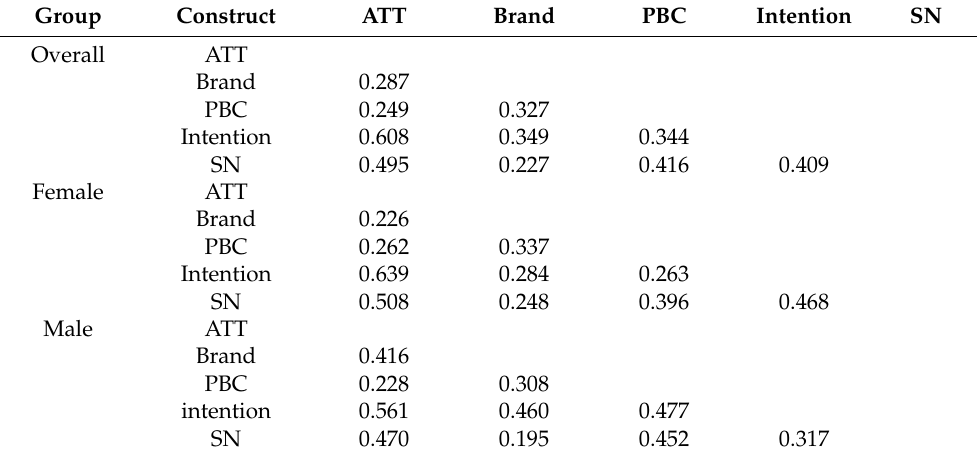
Table 3. Discriminant validity (hetero-trait mono-trait